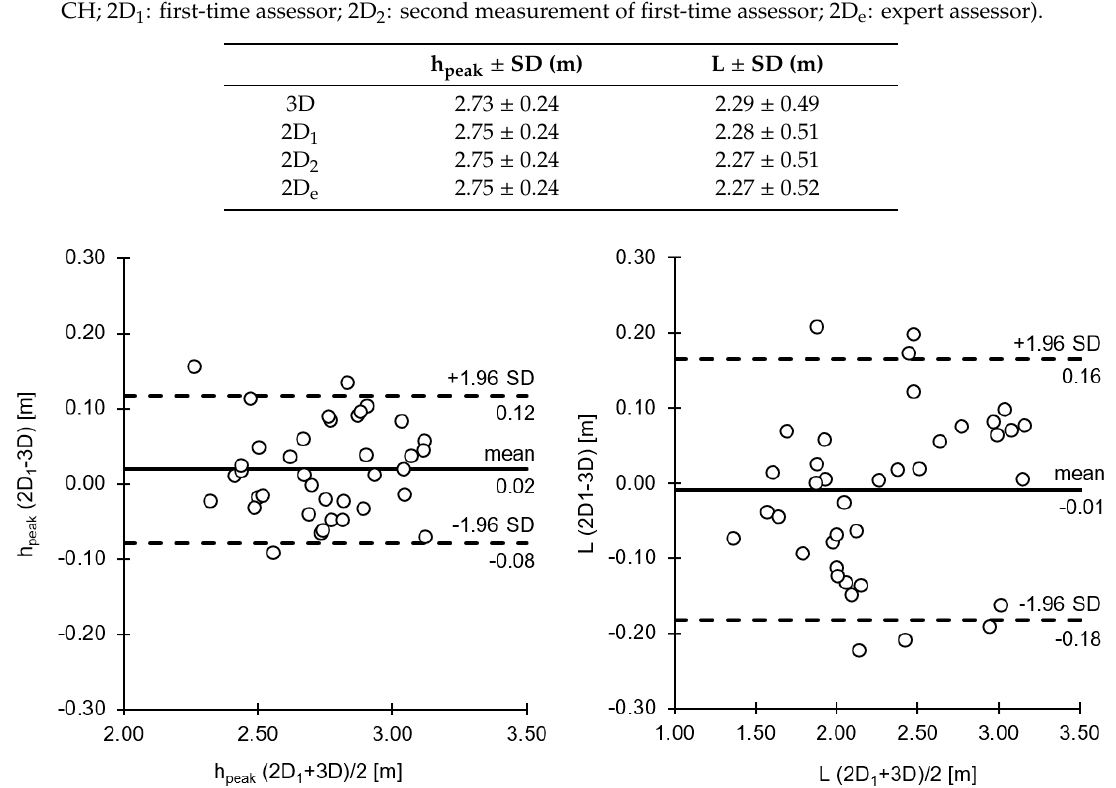
Figure 5. Validity: Bland–Altman diagrams comparing 2D and 3D analyses of peak height (h peak ) Table 2. Random error (CV%), typical error (TE), correlation coefficient, and systematic error (p) of and length of flight (L) of vaults (n = 38). 2D 1 : two-dimensional video analysis with Dartfish SA of a peak height (h peak ) and length of flight (L) of vauls, when comparing first 2D video analysis (2D 1 ) first-time assessor); 3D: three-dimensional motion capture with Vicon Motion evaluations to 3D motion capture (validity) and to second 2D analysis (intrarater reliability), as well as second 2D video analysis (2D 2 ) and expert 2D video analysis (2D e ) (interrater reliability).